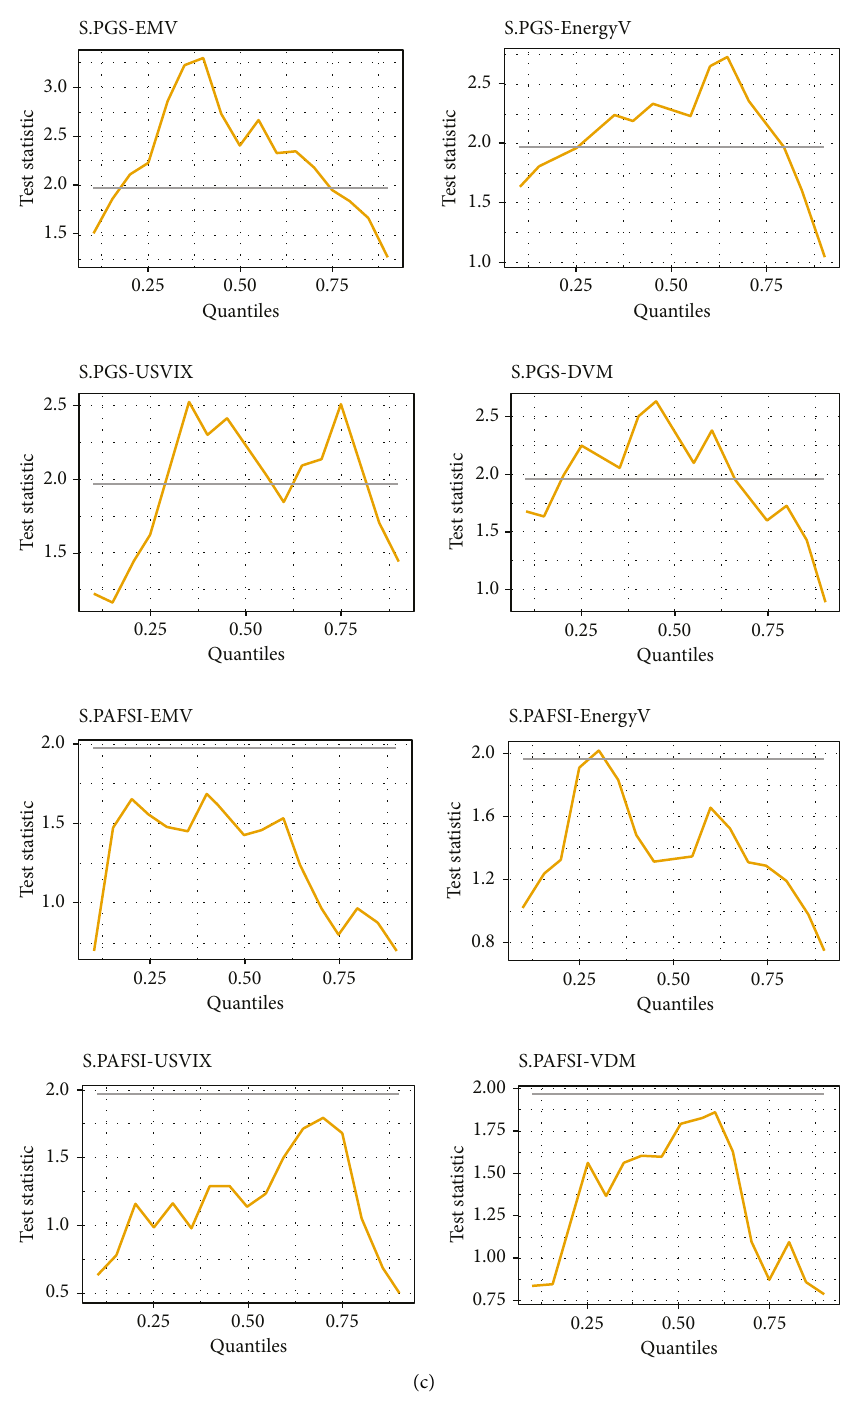
Figure 4: Causality in mean at various